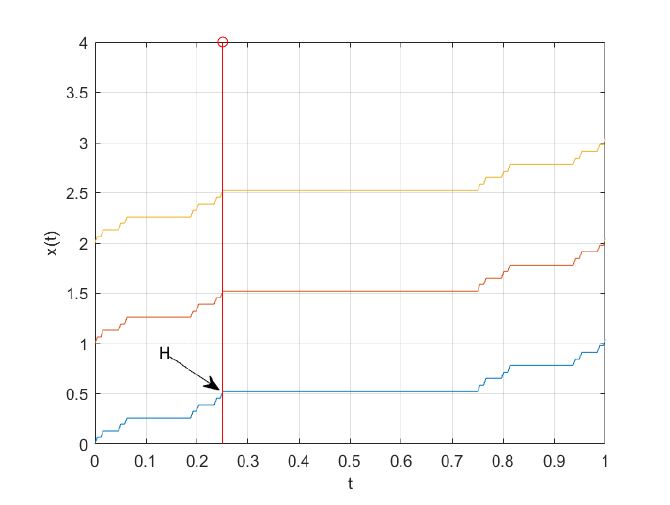
Figure 3. Orbit of point H